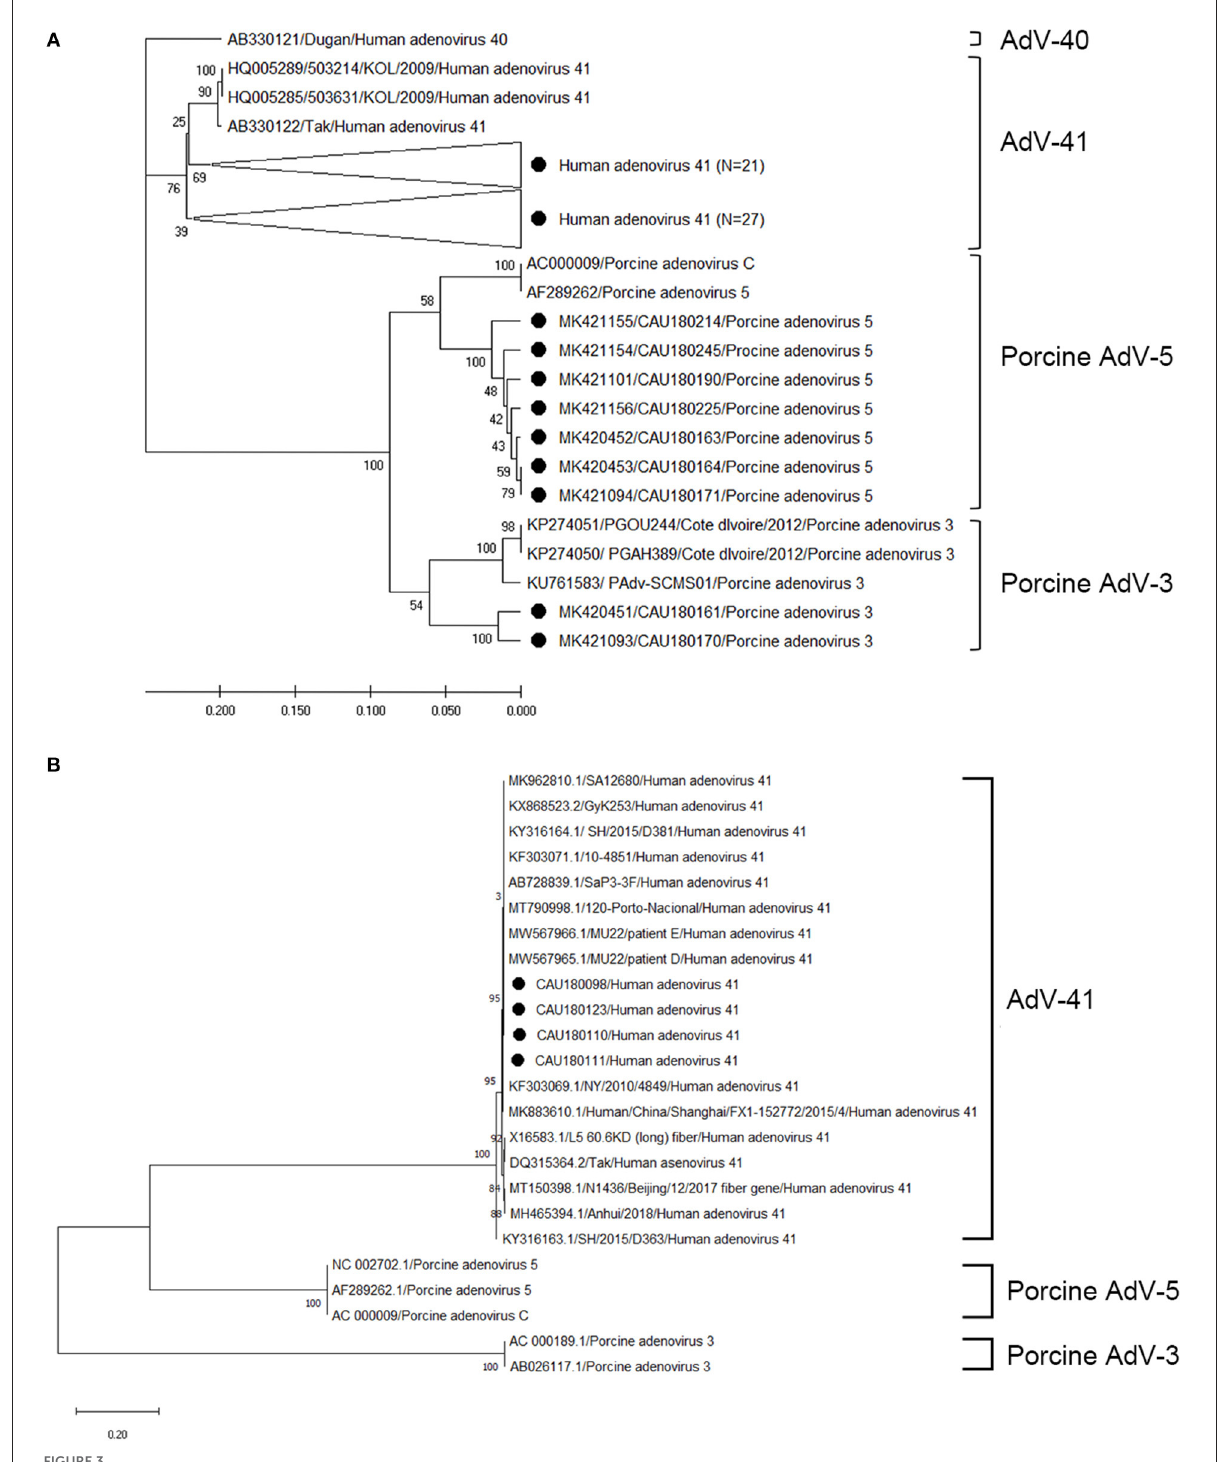
FIGURE3 Phylogenetic tree of AdV detected in porcine stools and swabs. Sequences detected in this study are represented as black circles (•). (A) Phylogenetic tree analysis for the AdV hexon gene using the UPGMA method and based on the 171-bp sequence. Here, AdV-41 (three strains), AdV-40 (one strain), porcine AdV-5 (two strains), and porcine AdV-3 (three strains) were used as reference sequences. Large triangles ( (cid:1) ) on the phylogenetic tree represent the compression of a subtree with a genetic relationship, with the numbers of compressed sequences shown in parentheses. (B) Phylogenetic tree analysis for AdV (662-bp of the fiber gene) using the maximum likelihood method. Here, AdV-41 (15 strains), porcine AdV-5 (three strains), and porcine AdV-3 (two strains) were used as reference sequences. The numbers at the nodes of the tree indicate bootstrap values and the scale bar indicates nucleotide substitutions per